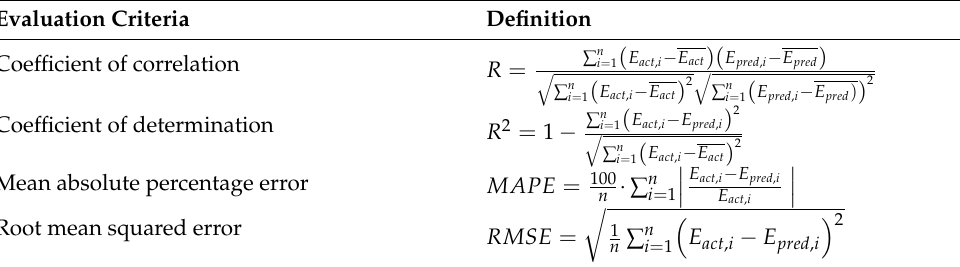
Table 4. Model performance evaluation criteria.